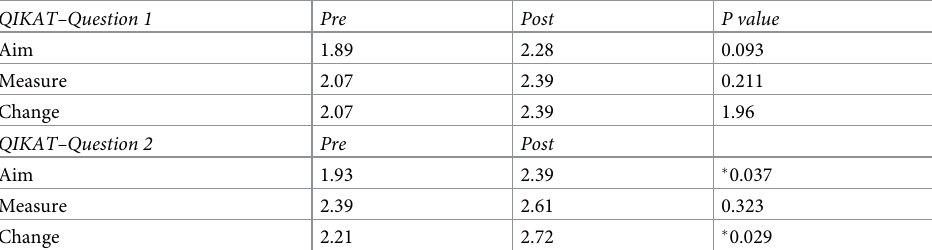
Table 2. Difference in QIKAT scores pre and post QI